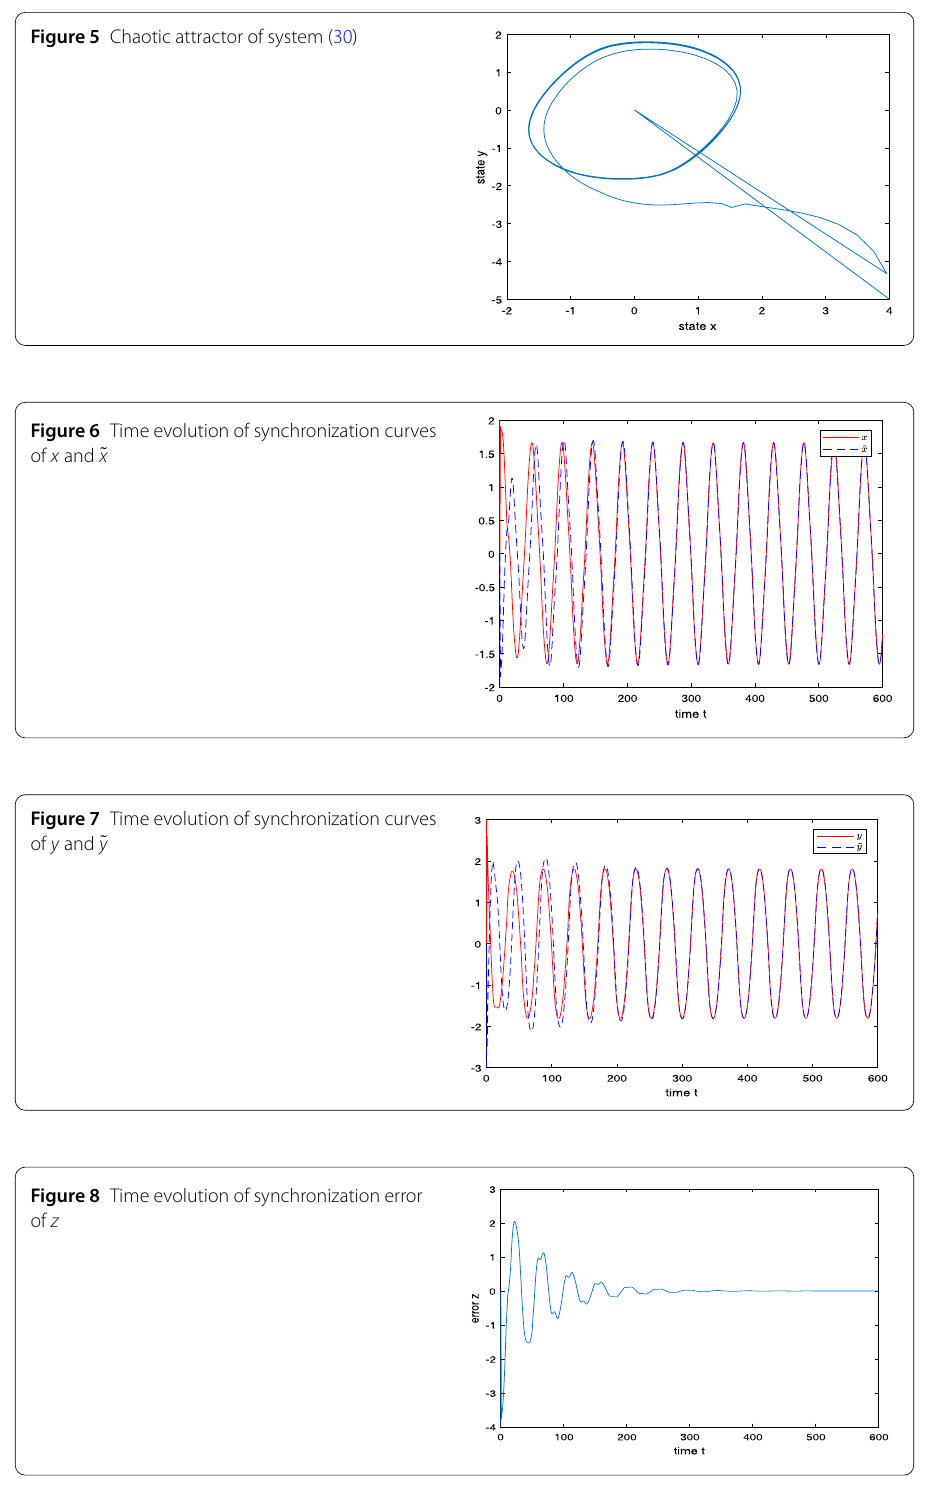
˘ ξ Taking μ = 0.01, ˘ μ = 0.01, ξ = 0.01, = 0.01 and setting initial values as w (0) = 0.05, ˘ w (0) = 0.2, u (0) = 0.25, ˘ u (0) = 0.2, Figs. 6–9 portray the time evolution regarding adap- tive synchronization curves and adaptive synchronization errors of systems (30) and